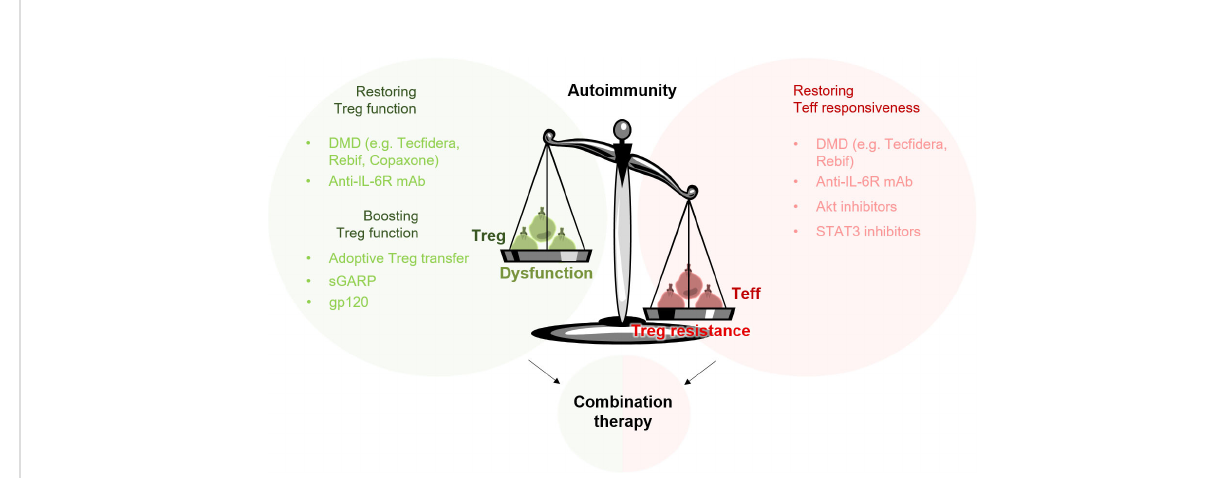
FIGURE 2 Targeting Treg resistance and Treg dysfunction in the treatment of autoimmune diseases. The imbalance of the immune system in patients with autoimmune diseases can be attributed to a disturbed function of Treg (Treg dysfunction) and to a reduced sensitivity of Teff to Treg-mediated suppression (Treg resistance). To rebalance the misguided immune system, a combination therapy targeting both sides – Treg dysfunction and Treg resistance – could be bene fi cial. Adoptive Treg transfer or Treg-speci fi c activators such as gp120 can provide an additional boosting of the suppressive properties of